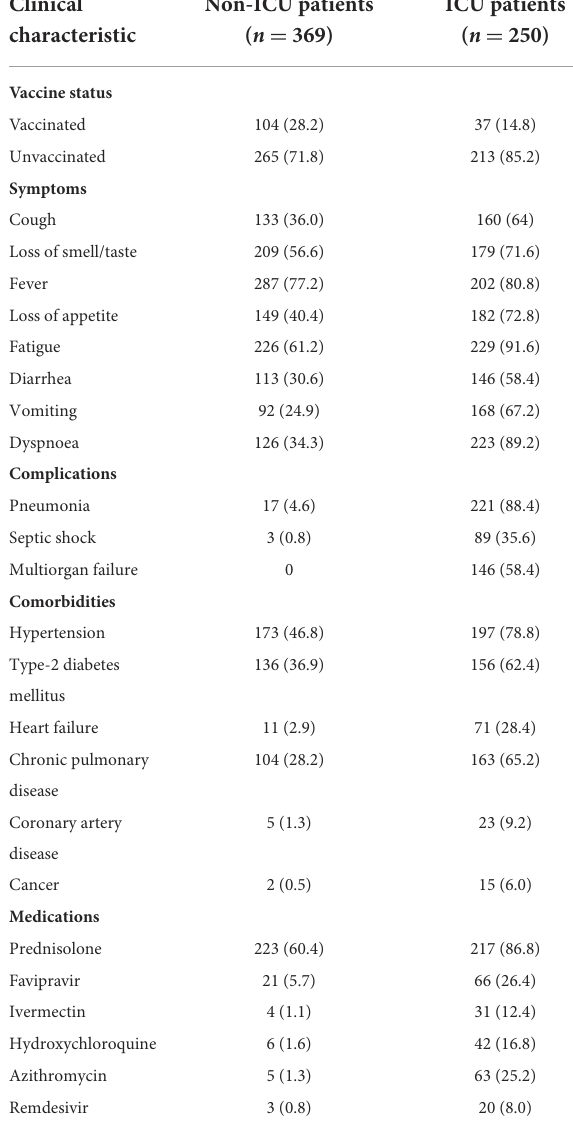
TABLE 1 Demographic characteristics of hospitalized COVID-19 patients.